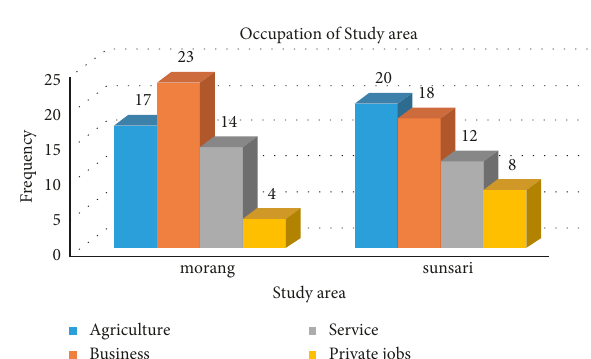
Figure 4: Occupational status of study